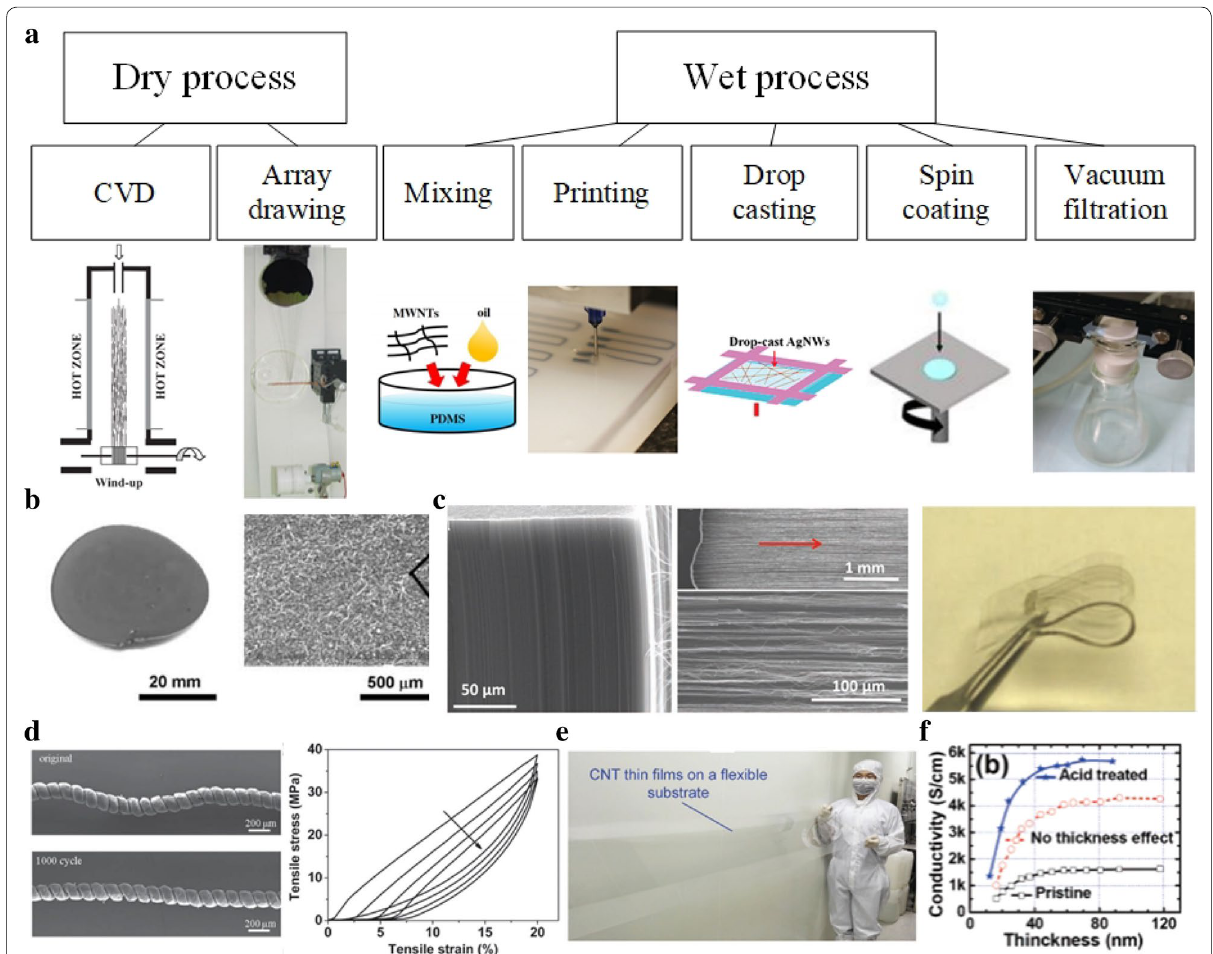
Fig. 2 a Commonly used fabrication process of a stretchable conductor. Reproduced with permission [60]. Copyright 2004. American Association for the Advancement of Science. Reproduced with permission [61–63]. Copyright 2006, 2014, 2012. Wiley–VCH. Reproduced with